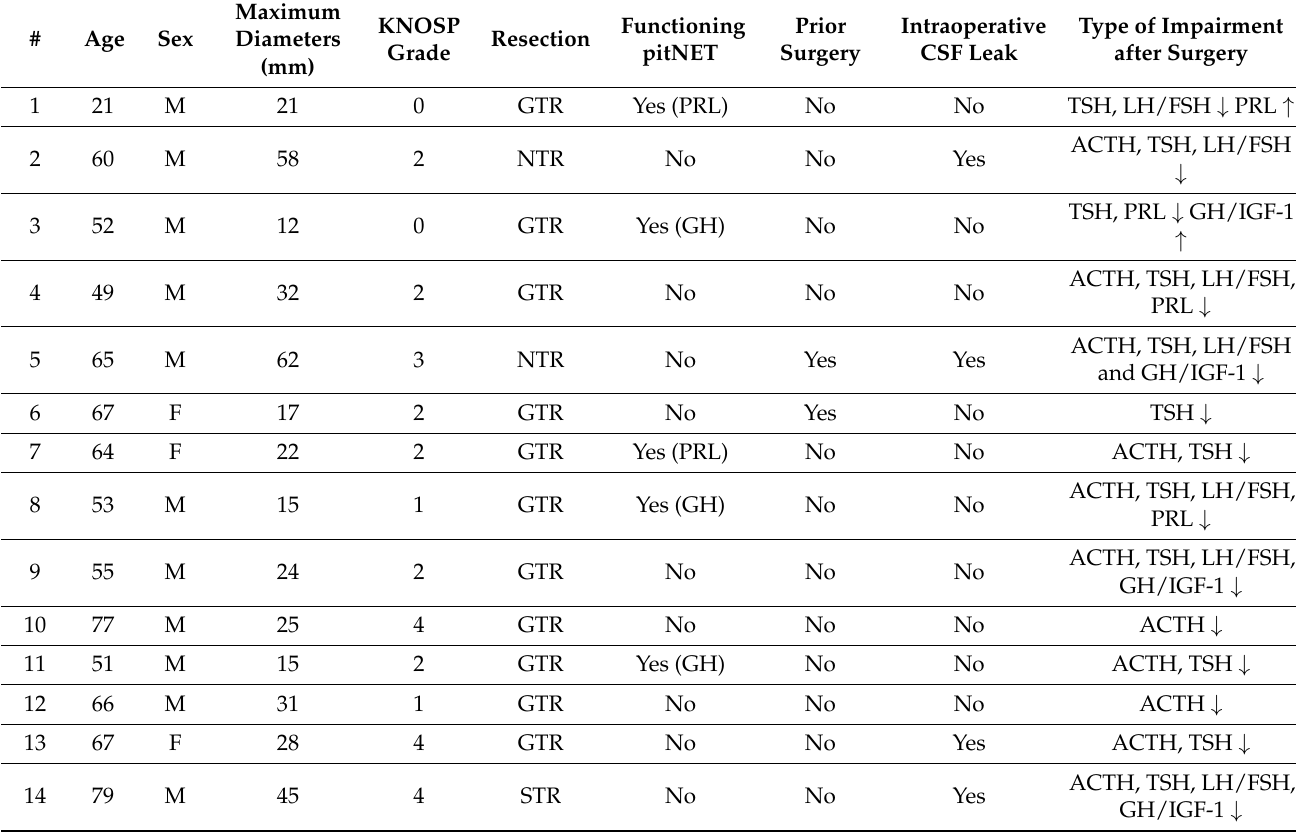
Table 2. Features’ description for patients who exhibited the onset of new pituitary deficiency after endoscopic transsphenoidal surgery (group 3). Legend: ↓ : under the reference value; ↑ : over the reference